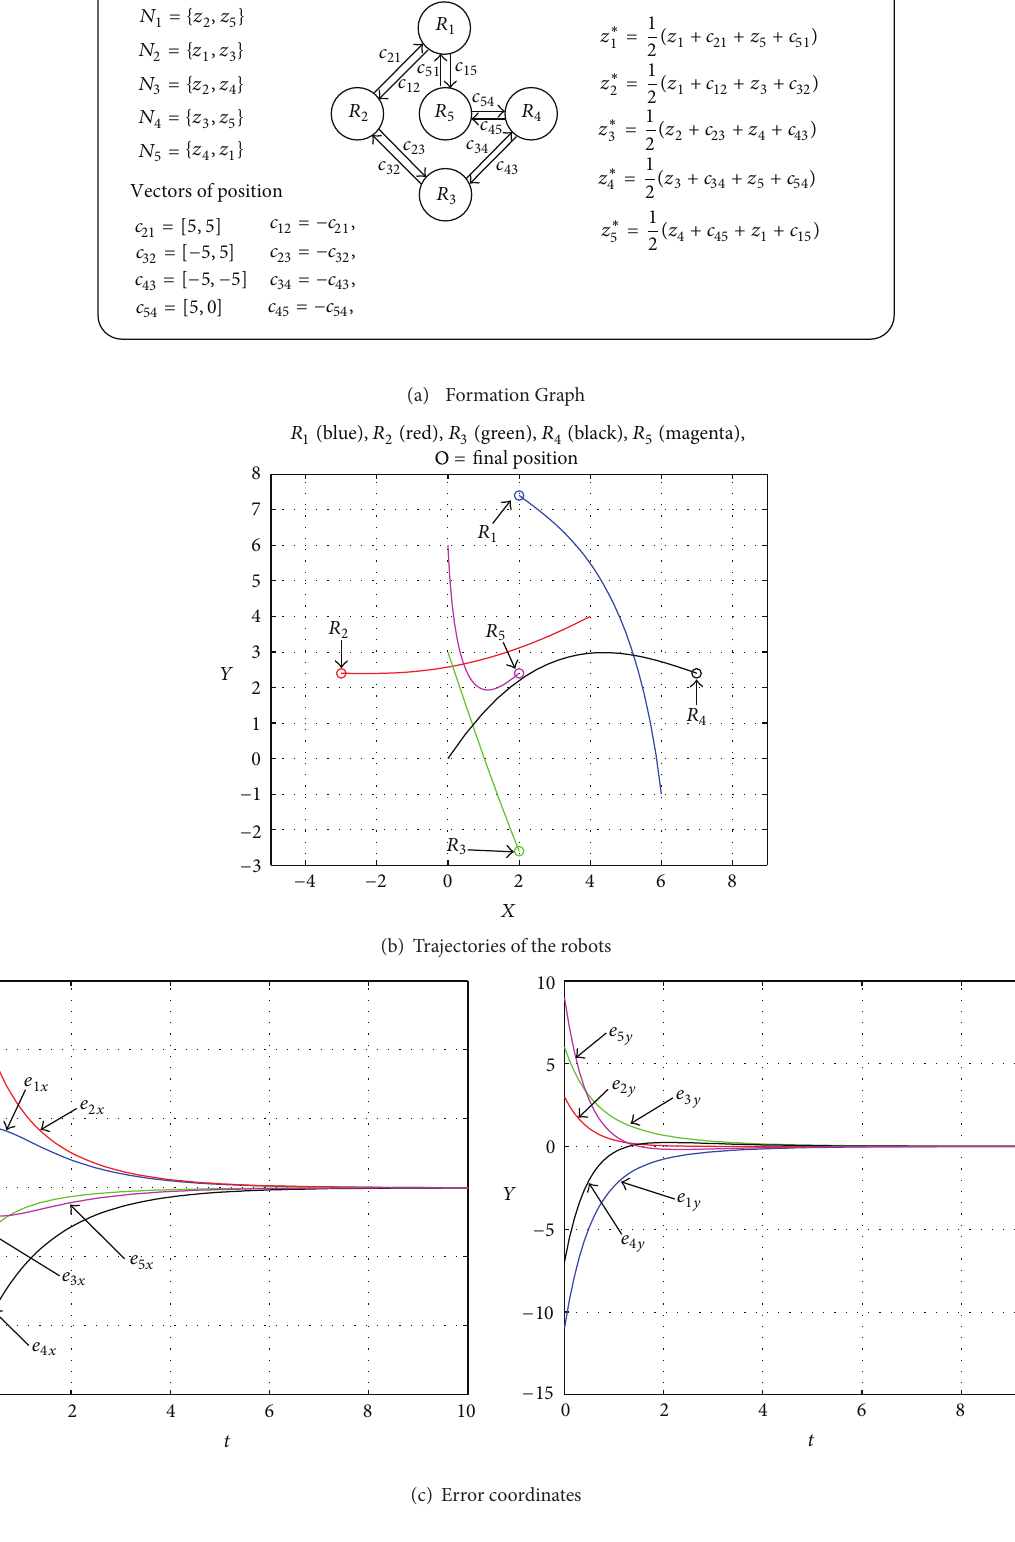
Figure 3: Formation control of an undirected cyclic pursuit